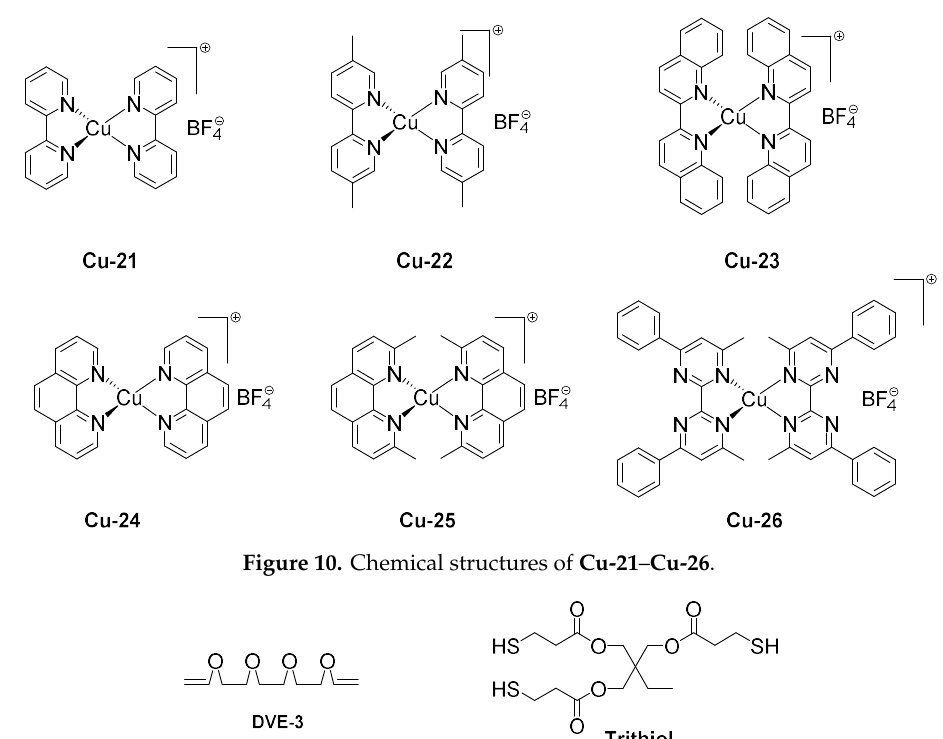
Figure 10. Chemical structures of Cu-21 – Cu-26 .